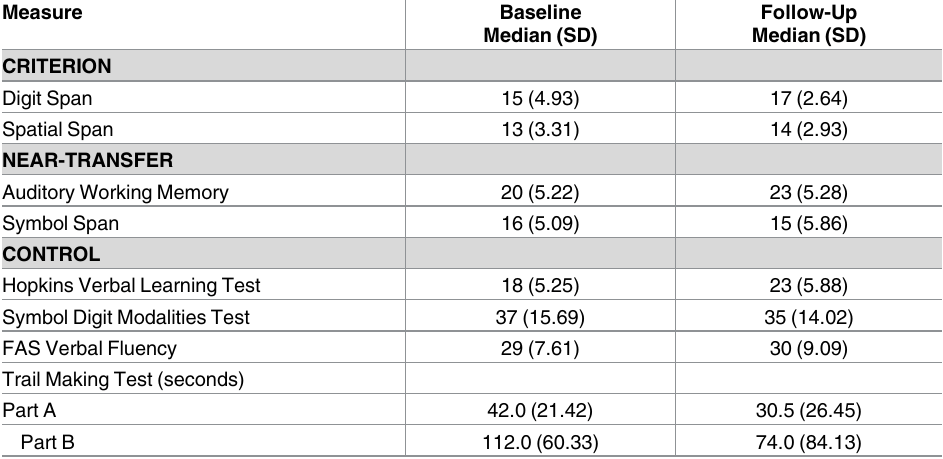
Table 4. Neuropsychological outcomes for criterion, near-transfer, and far transfer tasks using raw